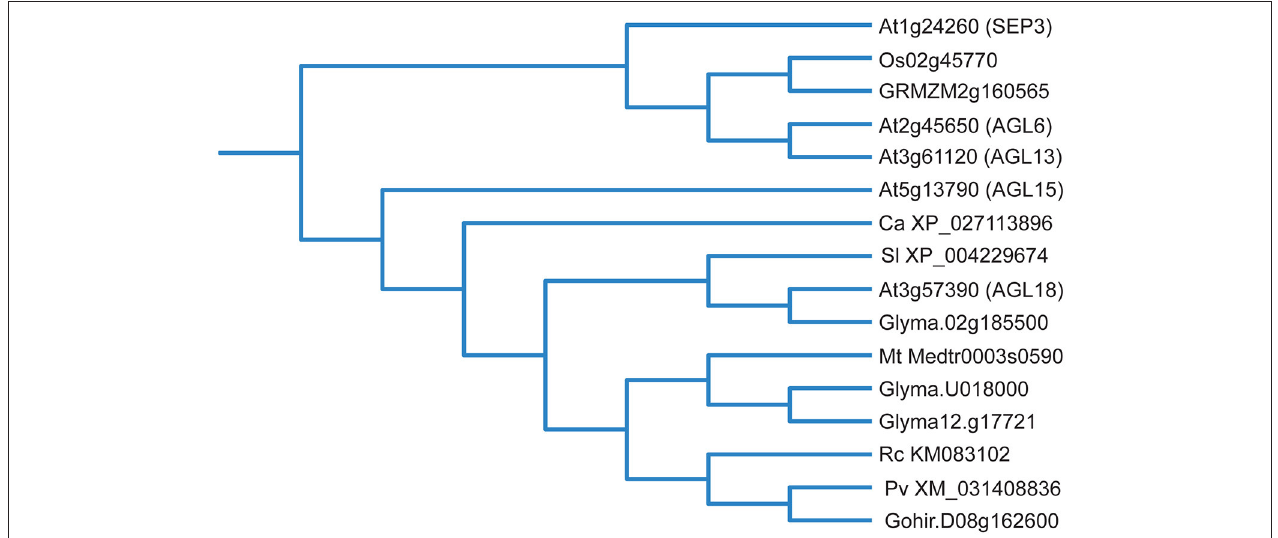
FIGURE 3 | Phylogenetic tree of selected potential AGL15 orthologs, some of which promote SE development (please see text). Protein sequences were retrieved from Phytozome (Goodstein et al., 2012) and submitted to the phylogenetic analysis tool NGPhylogeny.fr (Lemoine et al., 2019) with default settings. The output tree was then uploaded to iTOL (version 6.5) ( Letunic and Bork, 2019) for tree visualization. At, Arabidopsis thaliana; Os, Oryza sativa; GRMZM, Zea mays; Ca, Coffea arabica; Sl, Solanum lycopersicum; Glyma, Glycine max; Mt, Medicago truncatula; Rc, Rosa canina; Pv, Pistacia vera; Gohir, Gossypium hirsutum